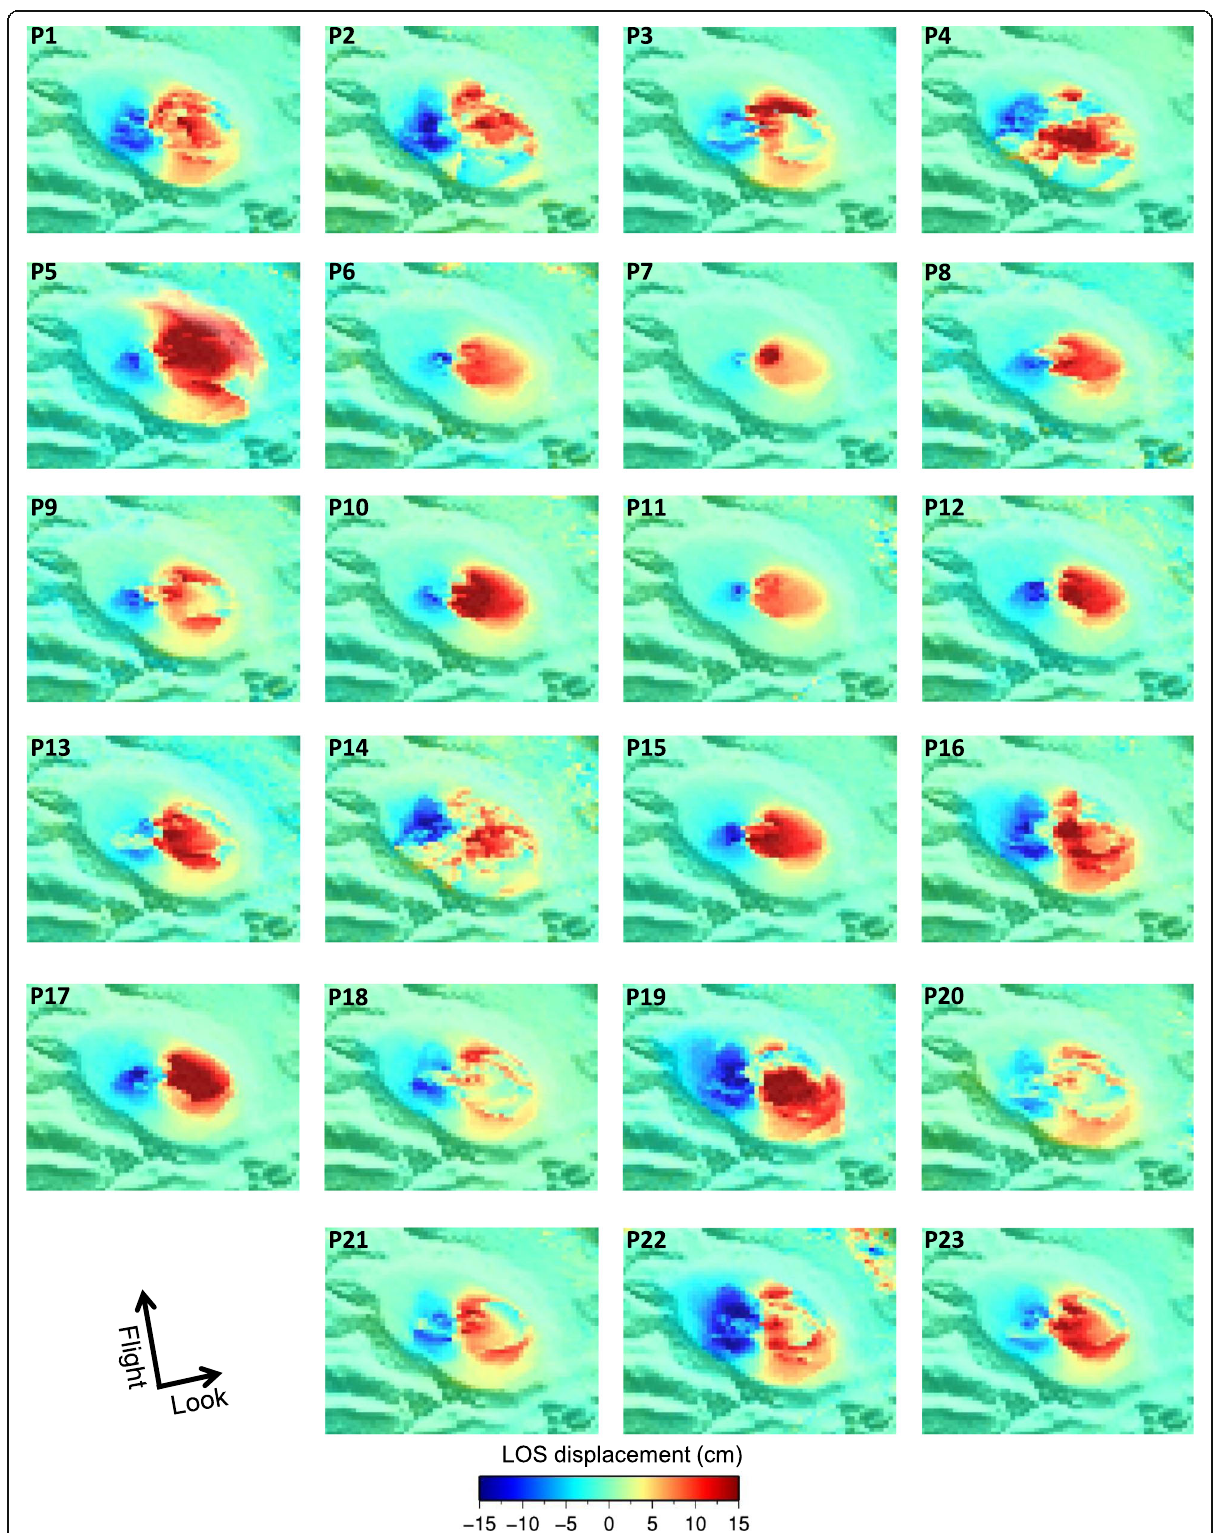
Fig. 3 Observed unwrapped InSAR images derived from ALOS/PALSAR ascending track data (path 573, frame 800). Positive and negative signals indicate the LOS changes away from and toward the satellite, respectively. Details of each data set are described in Table 1. Two arrows at the lower left indicate the satellite flight direction and beam radiation